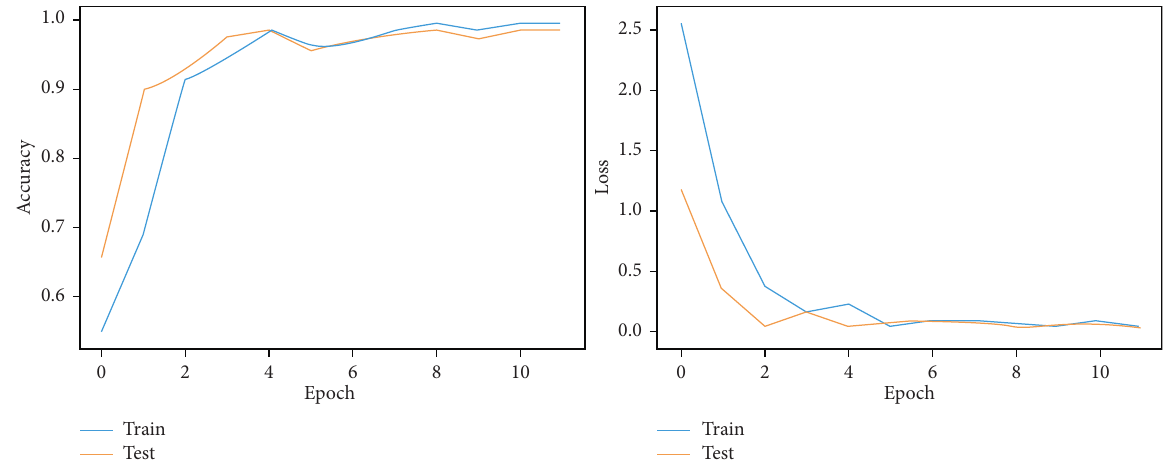
Figure 5: COVID-19-Net training accuracy and loss graph. Table 1: Binary class classification results: COVID-19 and non-